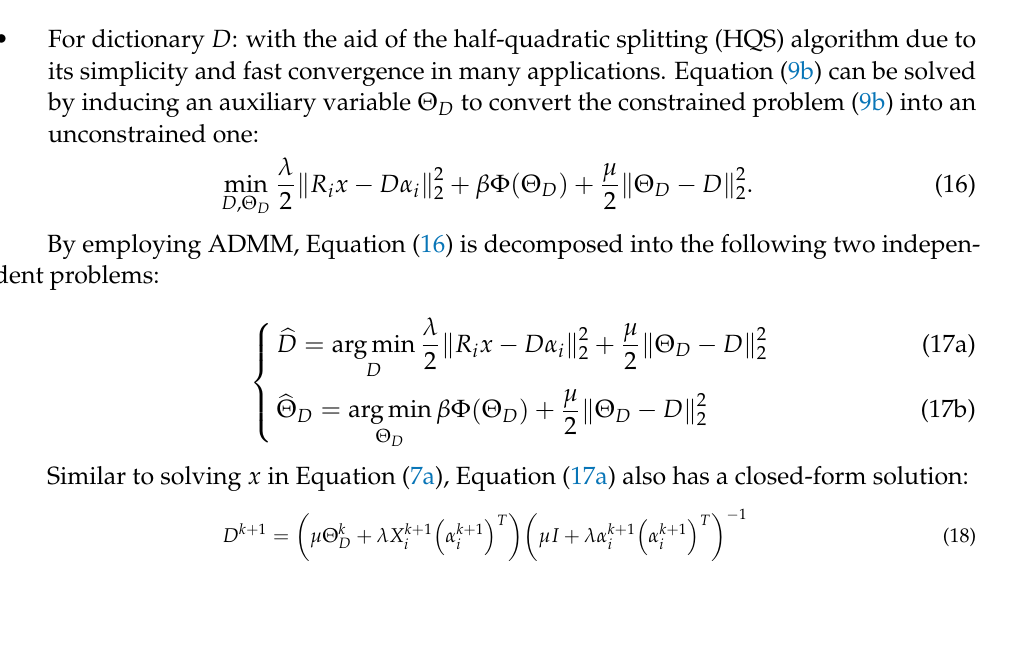
Figure 3. Framework of LISTA encoder for updating sparse coding α i